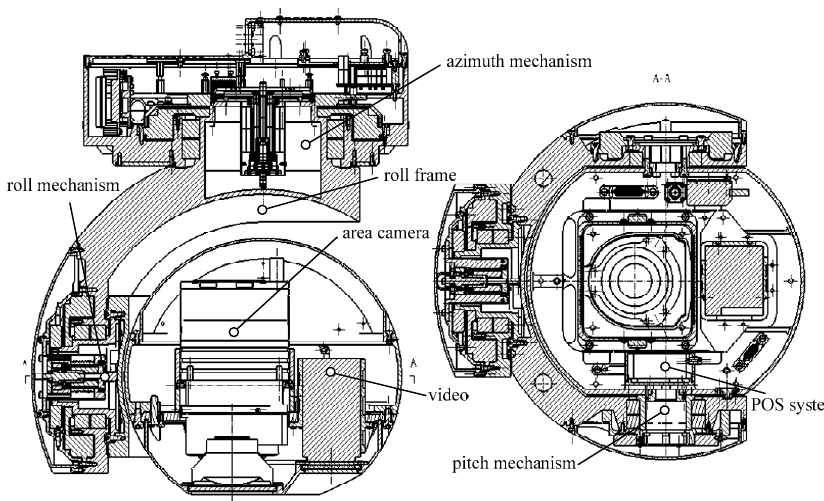
Figure 1. Mechanism of the three-axis inertially stabilized platform.